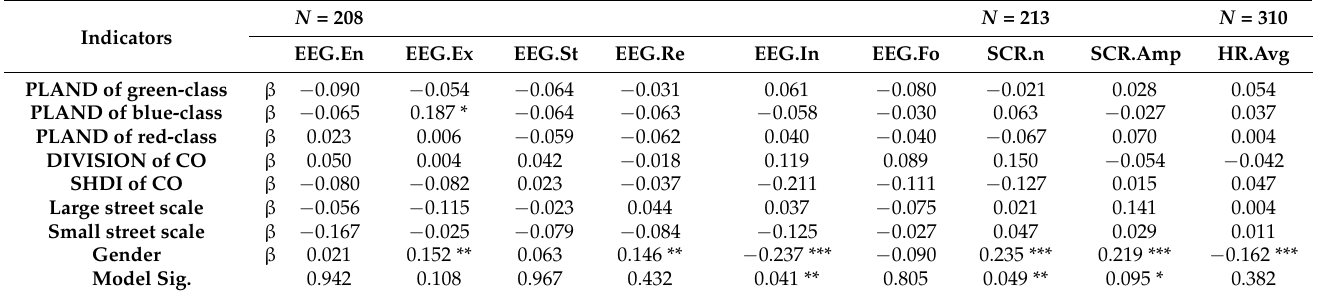
Table 5. Results of the linear regressions of the color composition characteristics on the physiological